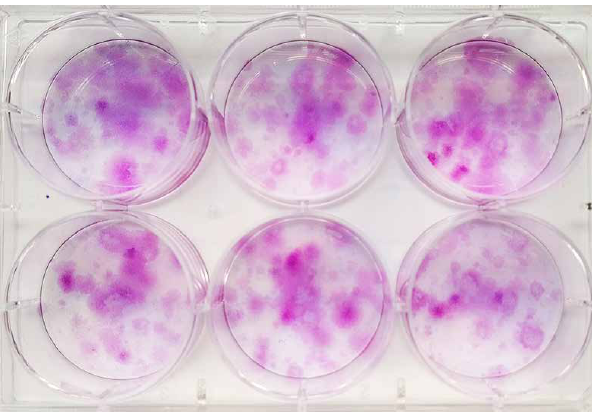
Figure 4: PDT for the different passages (mean ± SEM).